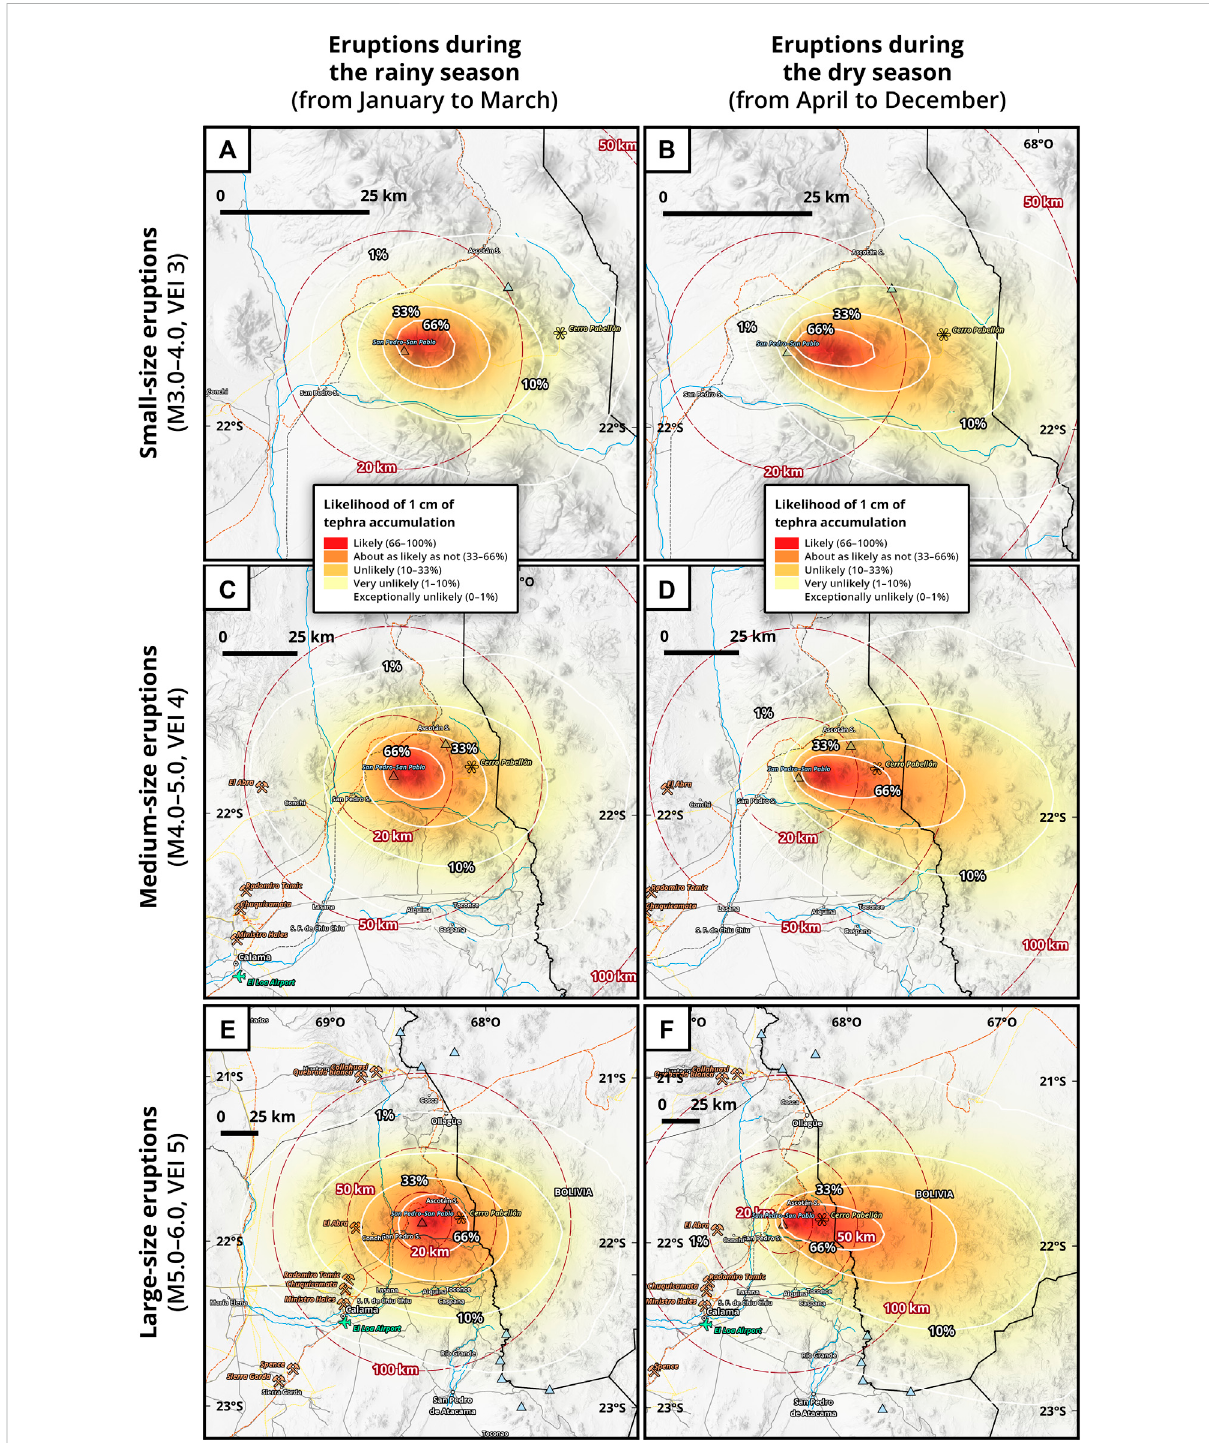
FIGURE 4 Likelihood maps of 1 cm of tephra fallout accumulation (alternatively: 10 kg m − 2 or 10 mm). (A,B) , likelihood maps of small-size eruptions of magnitude3.0 – 4.0(VEI3)(1:500,000scale); (C,D) ,likelihoodmapsofmedium-sizeeruptionsofmagnitude4.0 – 5.0(VEI4)(1:1,000,000scale); (E,F) , likelihood maps for large-size eruptions of magnitude 5.0 – 6.0 (VEI 5) (1:2,000,000 scale). (A,C,E) represent eruptions during the rainy season (from January to March); (B,D,F) depict eruptions during the dry season (from April to